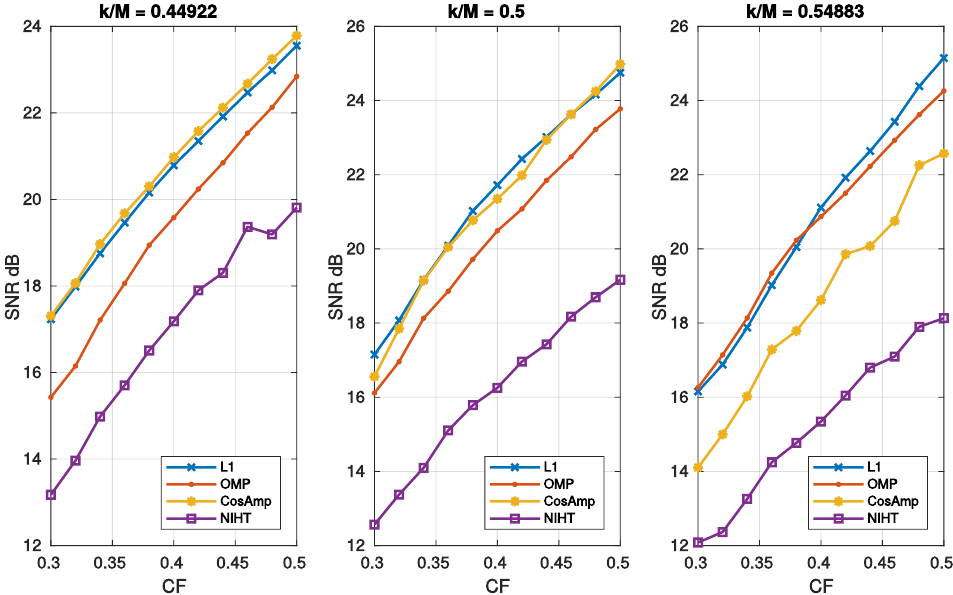
Figure 6. Case Study A—SNR as function of compression factor CF = M / N for the four algorithms and three values of sparsity S M = k / M